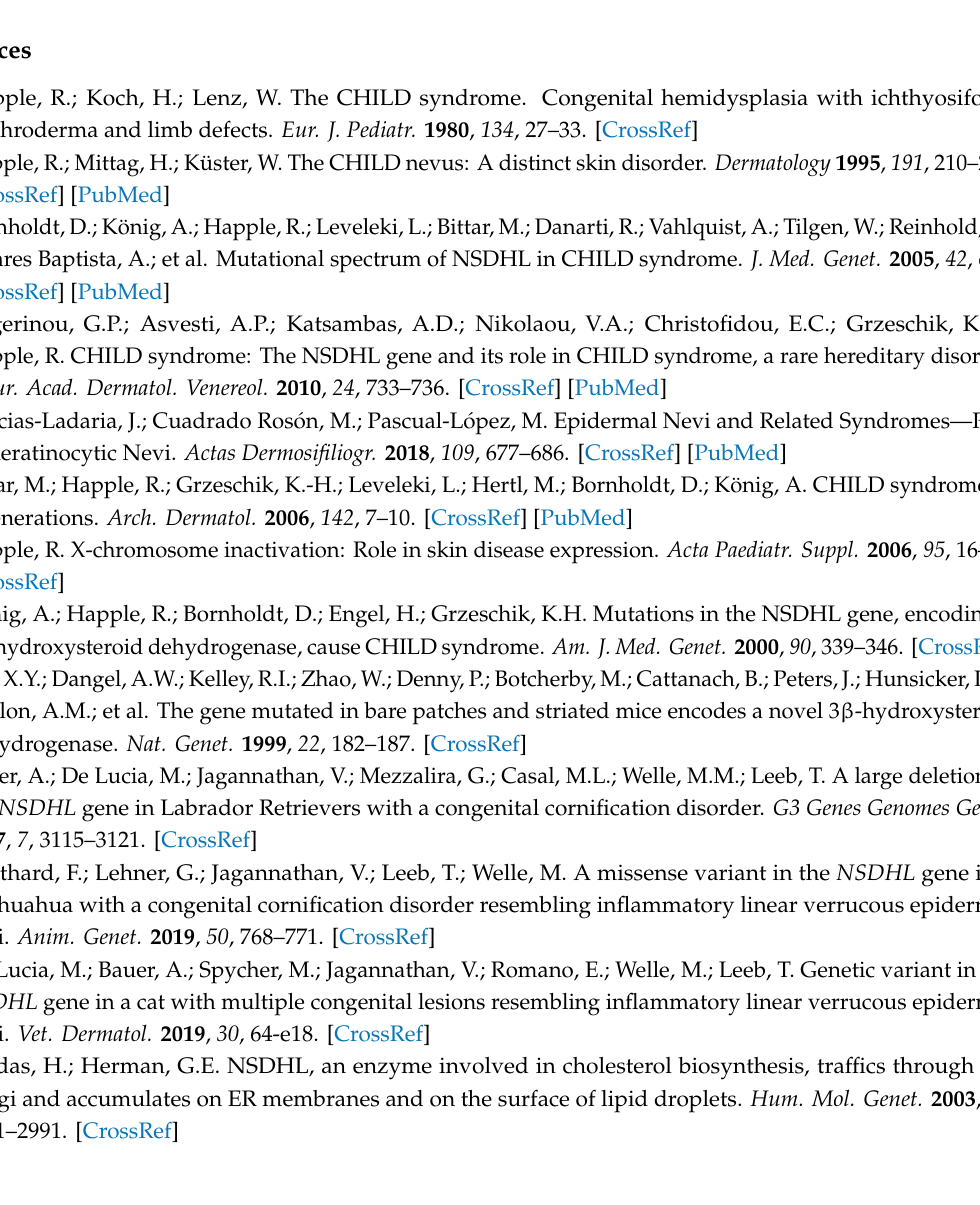
Table S1: Accession numbers of 647 dog and eight wolf sequences; Table S2: Primer sequences for the NSDHL